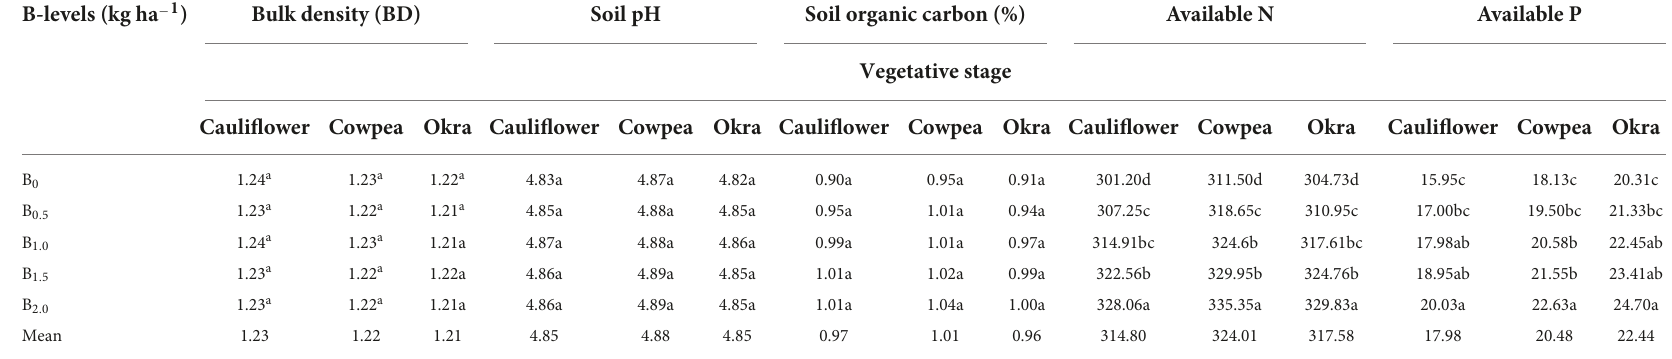
TABLE 1 Effect of graded B levels on soil physico-chemical properties at different crop stages in cauliflower-cowpea-okra cropping system (Pooled data 2015–017). B-levels (kg ha − 1